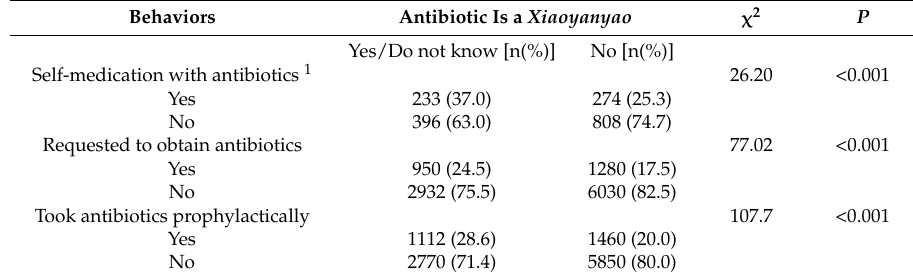
Table 2. The association between the misconception and antibiotic misuse behaviors by students (n =